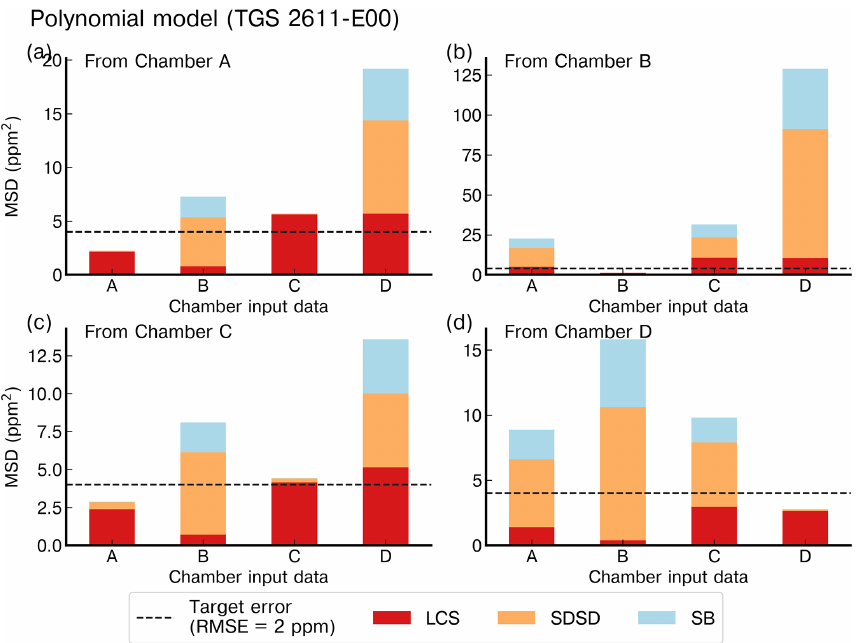
Figure 11. Reconstruction error of the peaks for the polynomial model with TGS 2611-E00 as input using the best stratified training case on (a) chamber A, (b) chamber B, (c) chamber C and (d) chamber D to reconstruct the peaks from the other chambers with data from the same type of sensor. Note the different ranges of the y